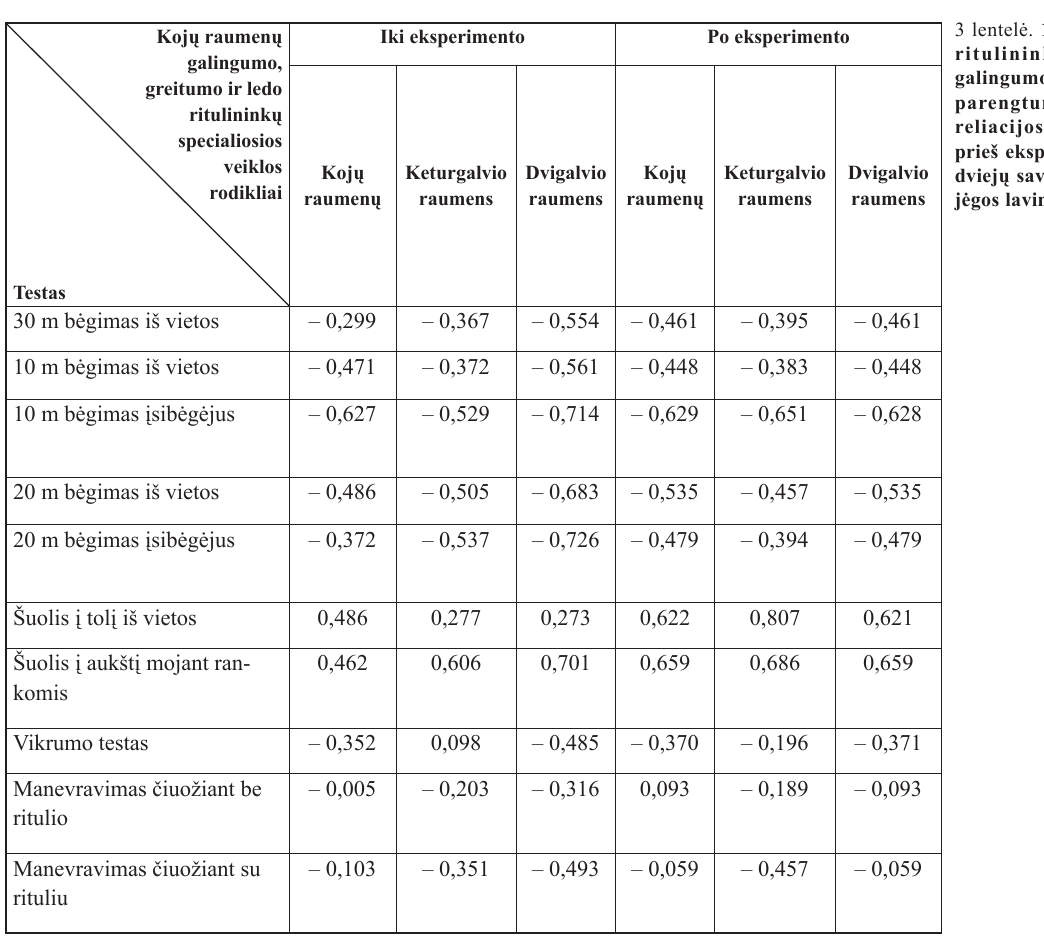
č iau padid ė jo koj ų dvigalvio raumens ir šuolio į tol į (r = 0,621) rodikli ų